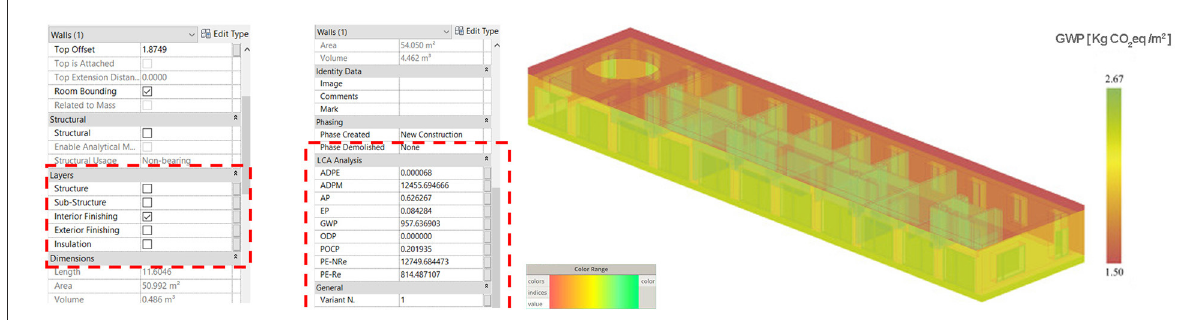
FIGURE5 Visualization of GWP impacts of the interior wall partitions and finishes through a .dyn color coding of the technical elements in Revit.